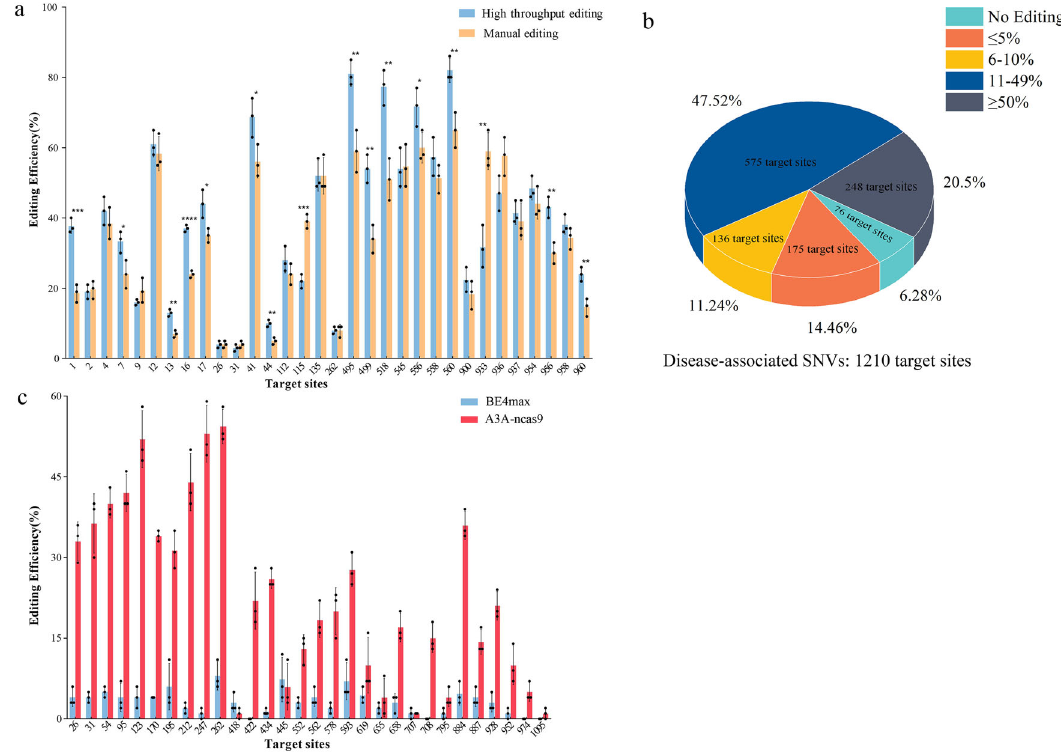
** p <0.01, *** p <0.001, *** * p <0.0001comparedtoManualediting. b Characterization of the high-throughput gene editing system at 1210 endogenous genomic loci. c Comparison of the editing ef fi ciencies of BE4max and APOBEC3A-nCas9 at 30 genomic